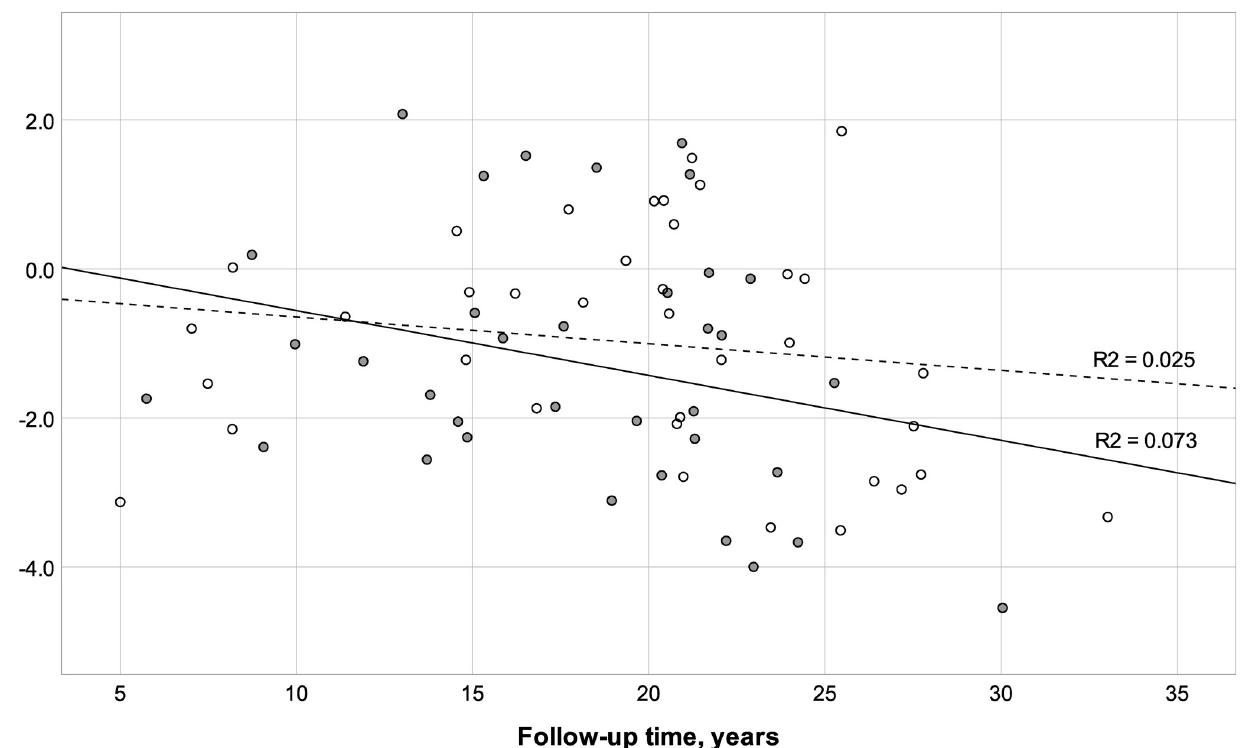
PLOS ONE | https://doi.org/10.1371/journal.pone.0274274 September 6,